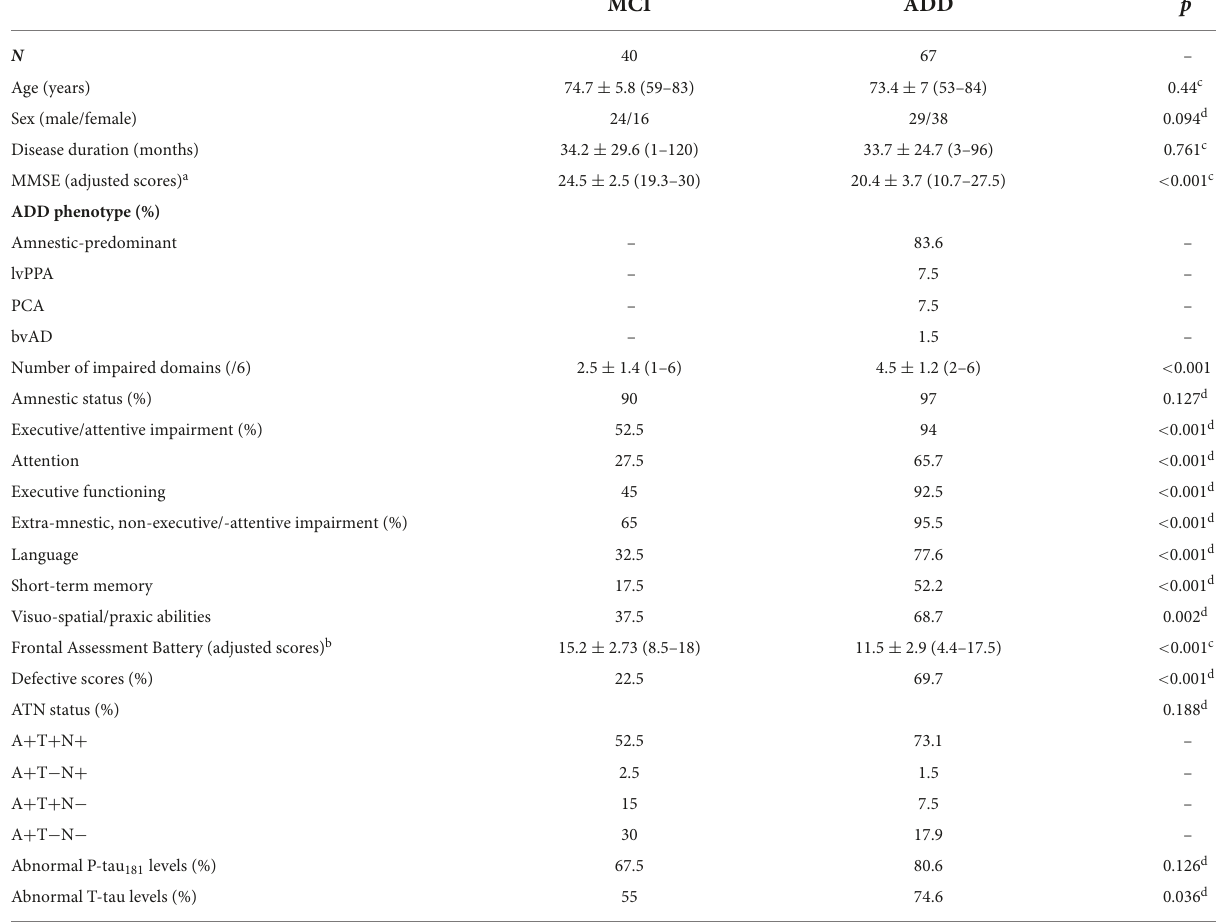
TABLE 1 Patients’ background and clinical